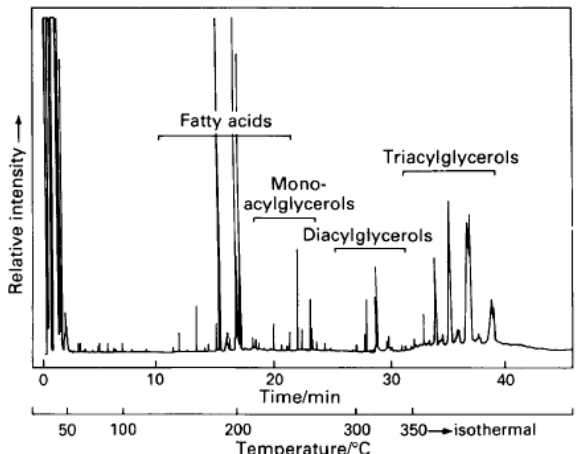
Figure 10. High-temperature GC. Analysis of intact fatty acid mono-, di- and triglycerides. Samples extracted from a sherd recov- ered from an Early Medieval ditch. Alumina cladded fused silica capillary column, immobilized stationary phase, end temperature 350°C. For details see text, Supplementary Information and ref. [81] . From ref. [81] with